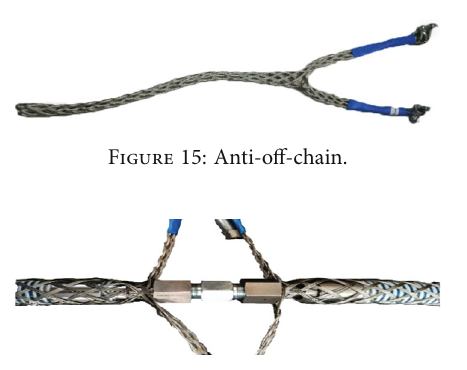
Figure 16: Use diagram of ultra-high-pressure hose and antistripping